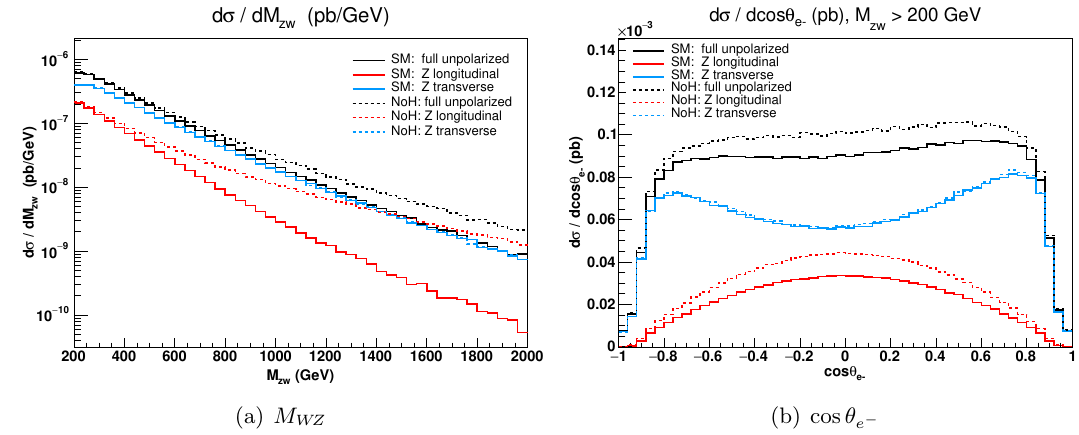
Figure 19 . W + Z scattering: comparison of Standard Model (solid) and Higgsless model (dashed) distributions in M WZ and cos (cid:18) . Polarized distributions concern the Z boson. The full set of e (cid:0) kinematic cuts (see section 5.1) is understood, including lepton and missing transverse momentum cuts, as well as neutrino